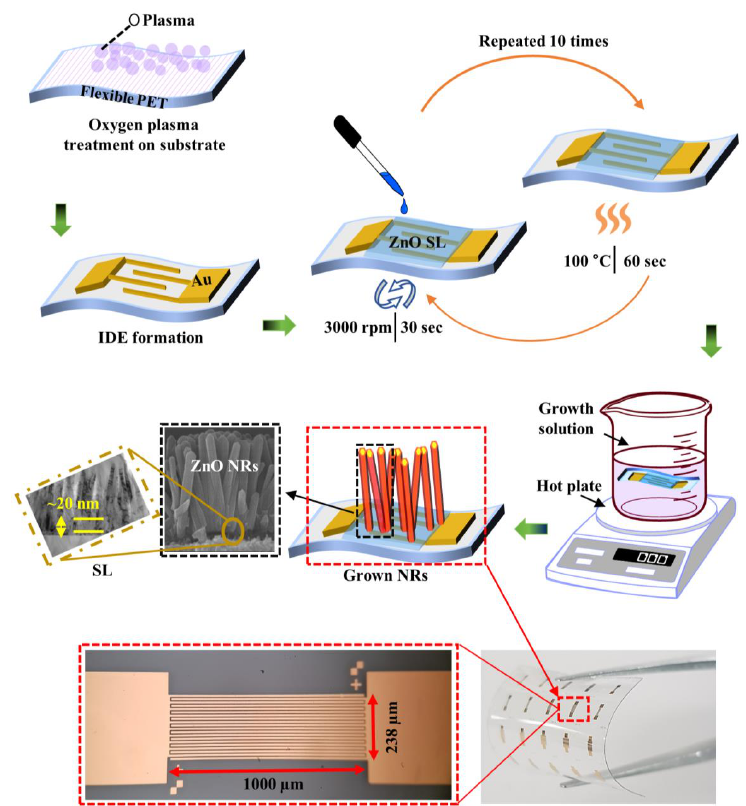
Figure 1. (Top) Schematics of process flow for the ultraviolet (UV) photodetector (PD) devices prepared with ZnO nanorods (NRs) via hydrothermal growth. Cross-sectional scanning electron microscopy (SEM) and transmission electron microscopy (TEM) views of as-grown NRs are shown in the bottom left insets. (Bottom-left) Fabricated PDs on polyethylene terephthalates (PET) substrates and (Bottom-right) a top-view of interdigitated electrode (IDE) pattern. Nanomaterials 2020 , 10 , x FOR PEER REVIEW